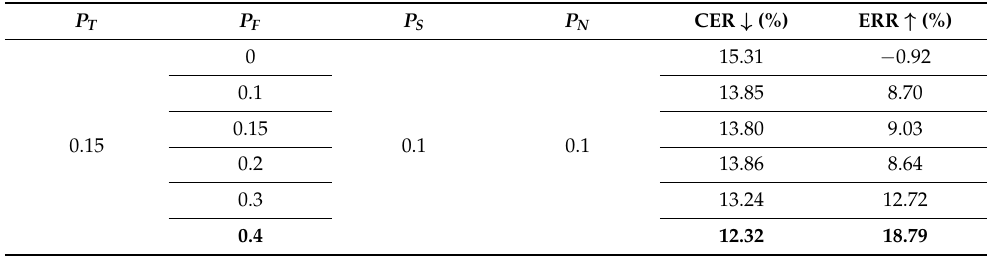
Table 9. ASR Performance comparison according to the variations of P F in the pretraining of the SVR model. All the results are from training the ASR model using the pretrained SVR extractor kept frozen. We report on the KsponSpeech ASR performance (Matched-SVR1K). The respective bolds denote the best hyperparameter and